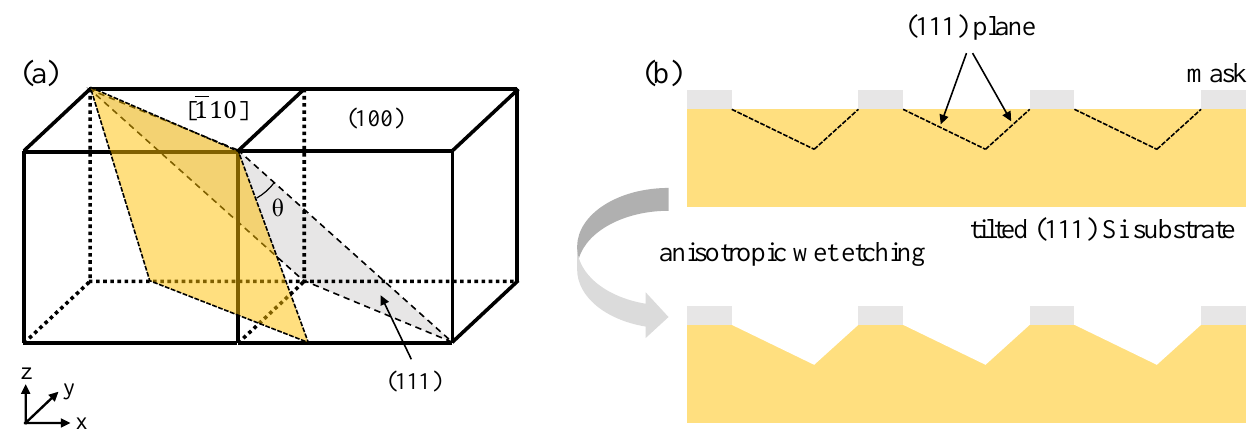
Figure 5. ( a ) The schematic diagram of tilted (111) silicon cutting; ( b ) formation of blazed grating groove by anisotropic wet etching.